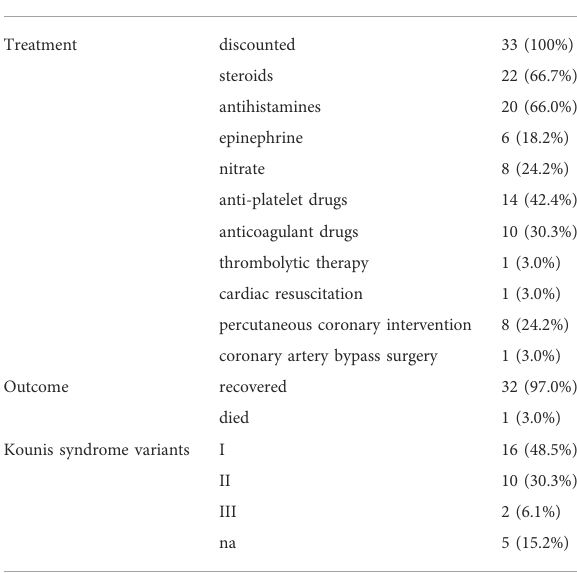
TABLE 4 Treatment and prognosis of 33 patients with amoxicillin- induced Kounis syndrome. Parameter